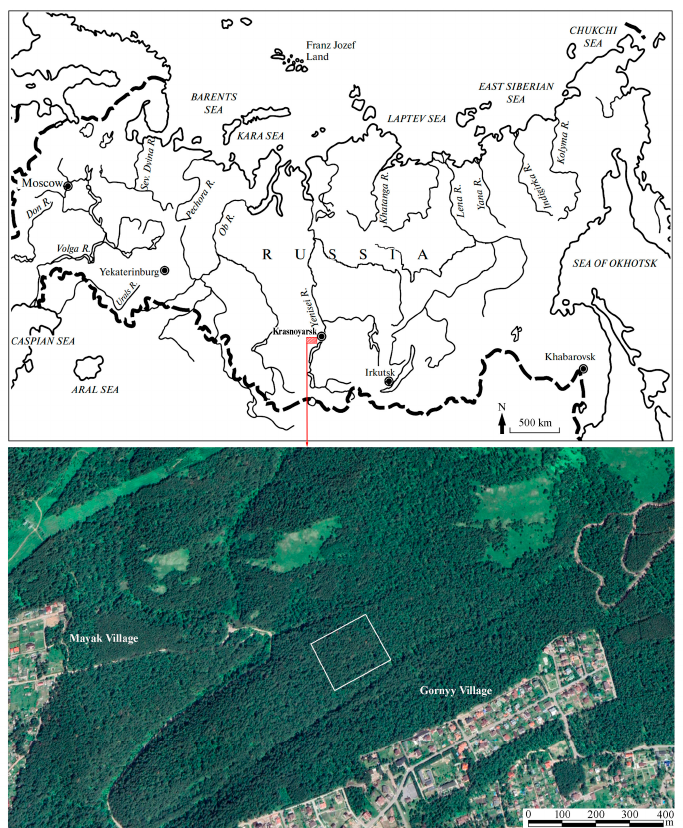
Figure 1. Geographical location of the sampling area. A red square on the upper image is the location on the Russia map. A white-boarded rectangle on the lower image is the site of tree sampling.